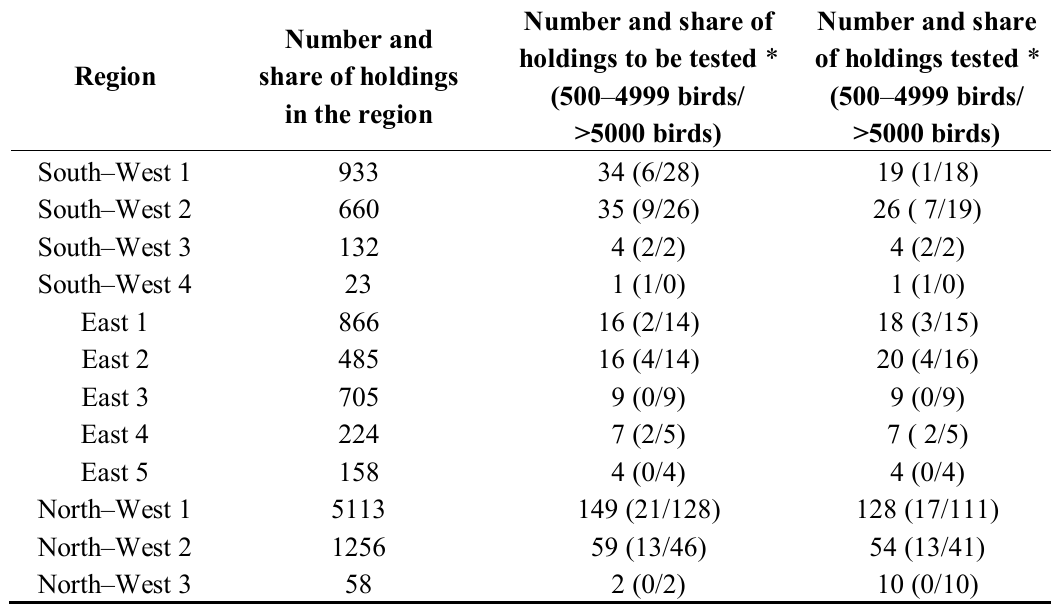
Table 1. Sampling plan and implementation of the baseline survey in turkey fattening flocks in Germany by Federal